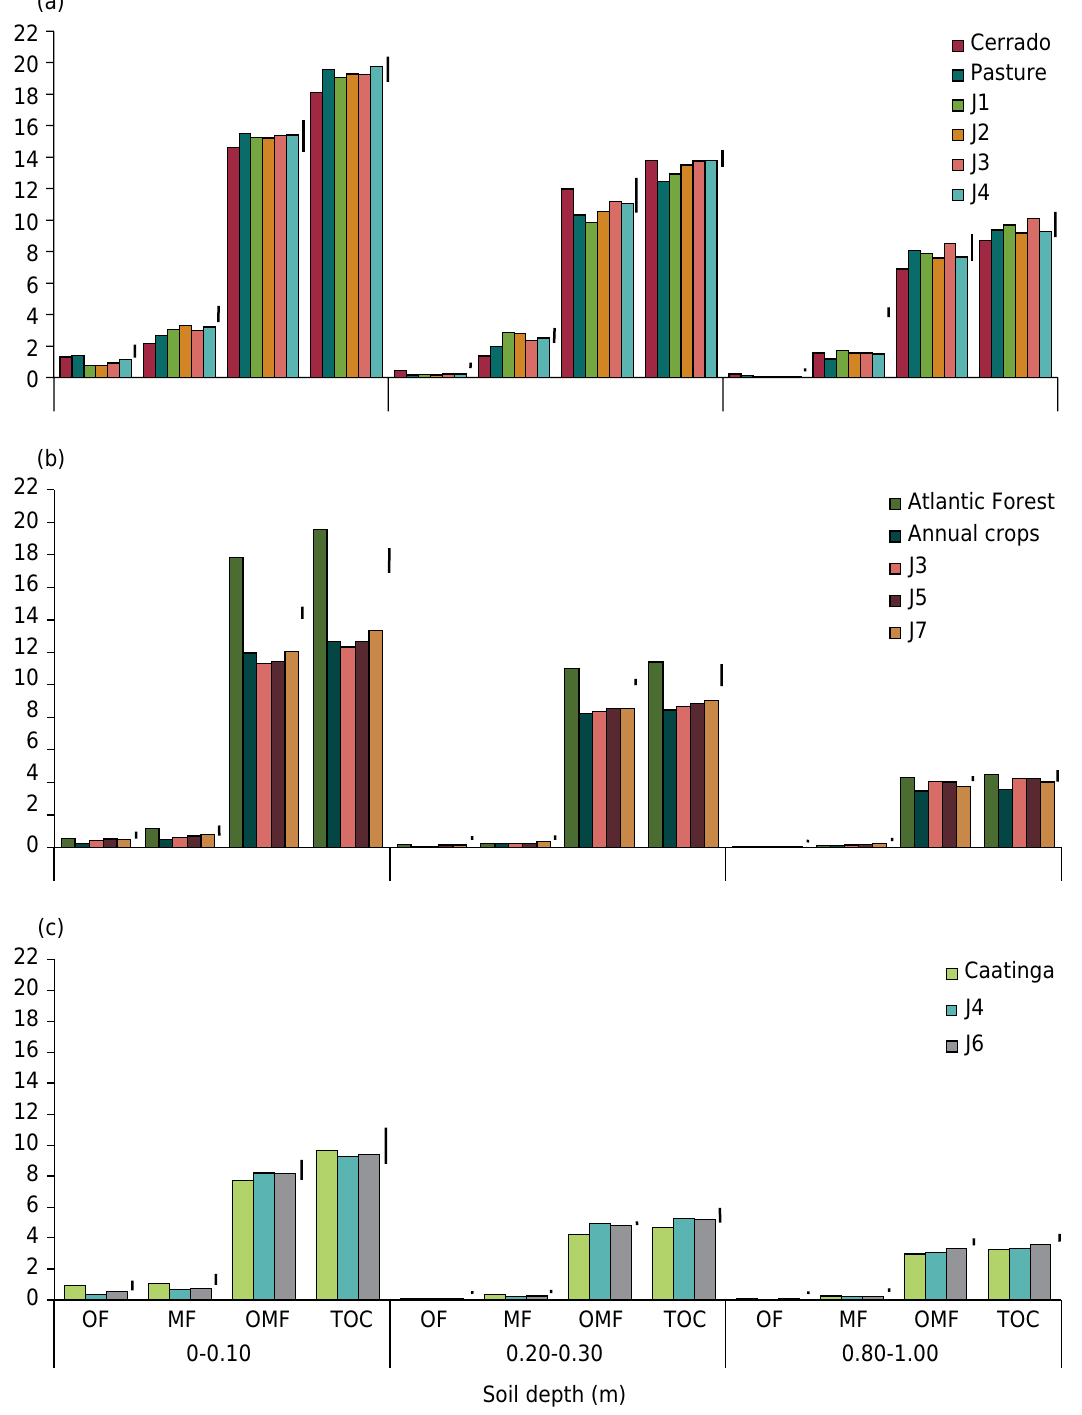
Figure 1. Concentrations of total organic carbon (TOC) and the organic fraction (OF), mineral fraction (MF), and organomineral fraction (OMF) of soil organic matter under different uses at depths of 0.00-0.10, 0.20-0.30, and 0.80-1.00 m in Planaltina-DF (a), Dourados-MS (b), and Araripina-PE (c), Brazil. The areas evaluated correspond to cultivation with Jatropha spp. over 1 (J1), 2 (J2), 3 (J3), 4 (J4), 5 (J5), 6 (J6), and 7 (J7) years, pasture, annual crops, and areas with native vegetation ( Cerrado , Atlantic Forest, and Caatinga ). Vertical lines represent a significant minimum difference by the Tukey test (α<0.05) between soil uses at the same depth and the same fraction or